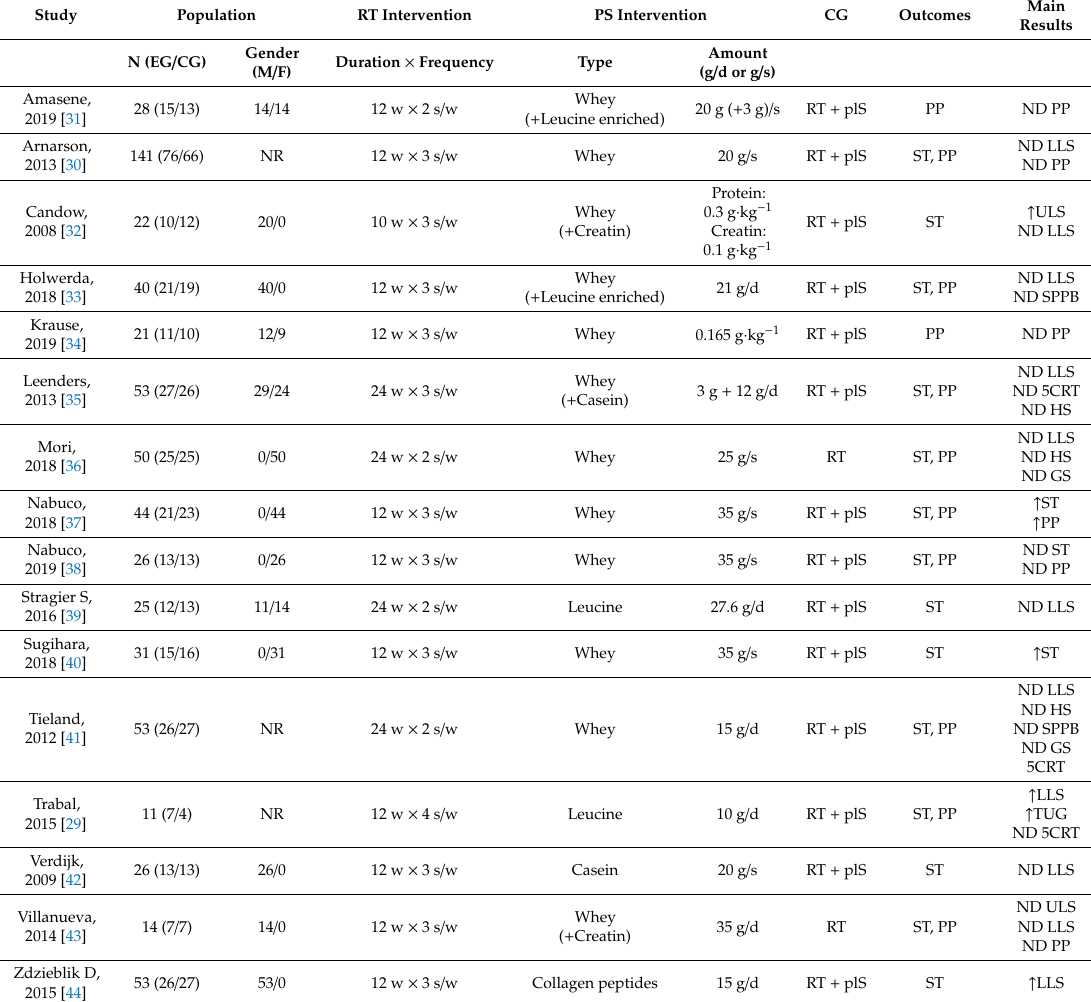
Table 3. Characteristics of the studies included in the qualitative